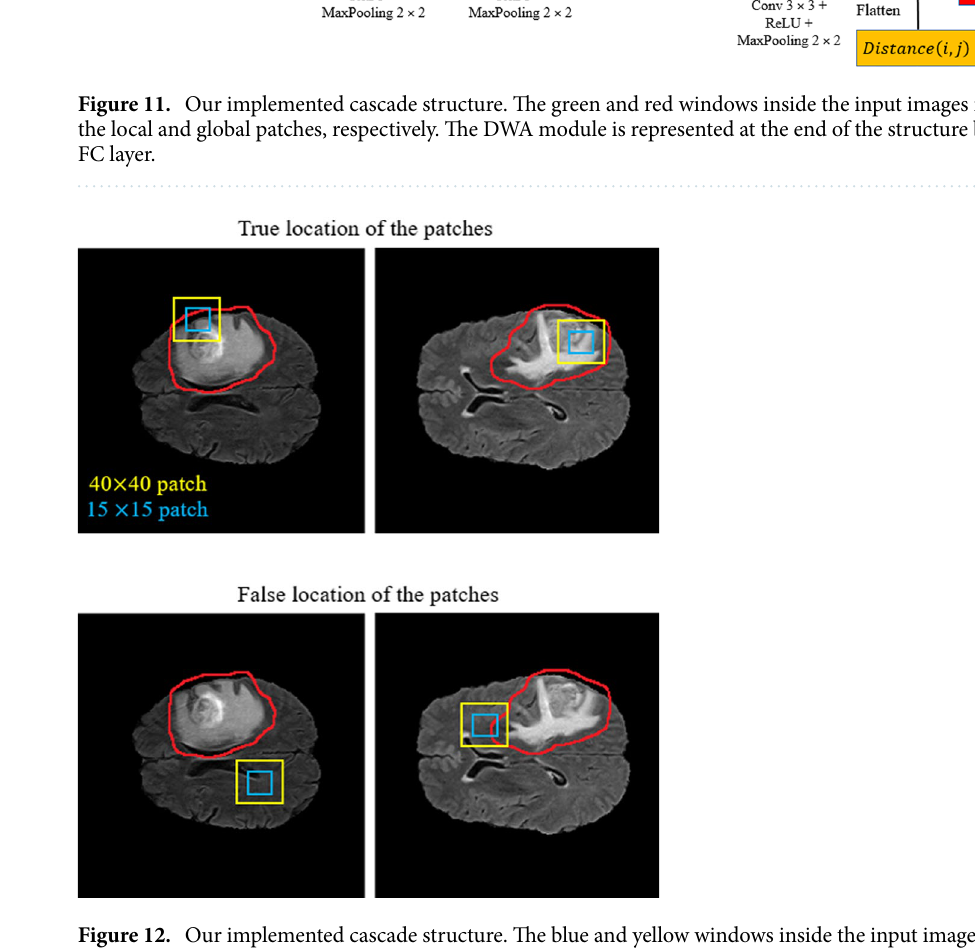
Figure 12. Our implemented cascade structure. The blue and yellow windows inside the input images represent the local and global patches, respectively. The red contour indicates the obtained expected